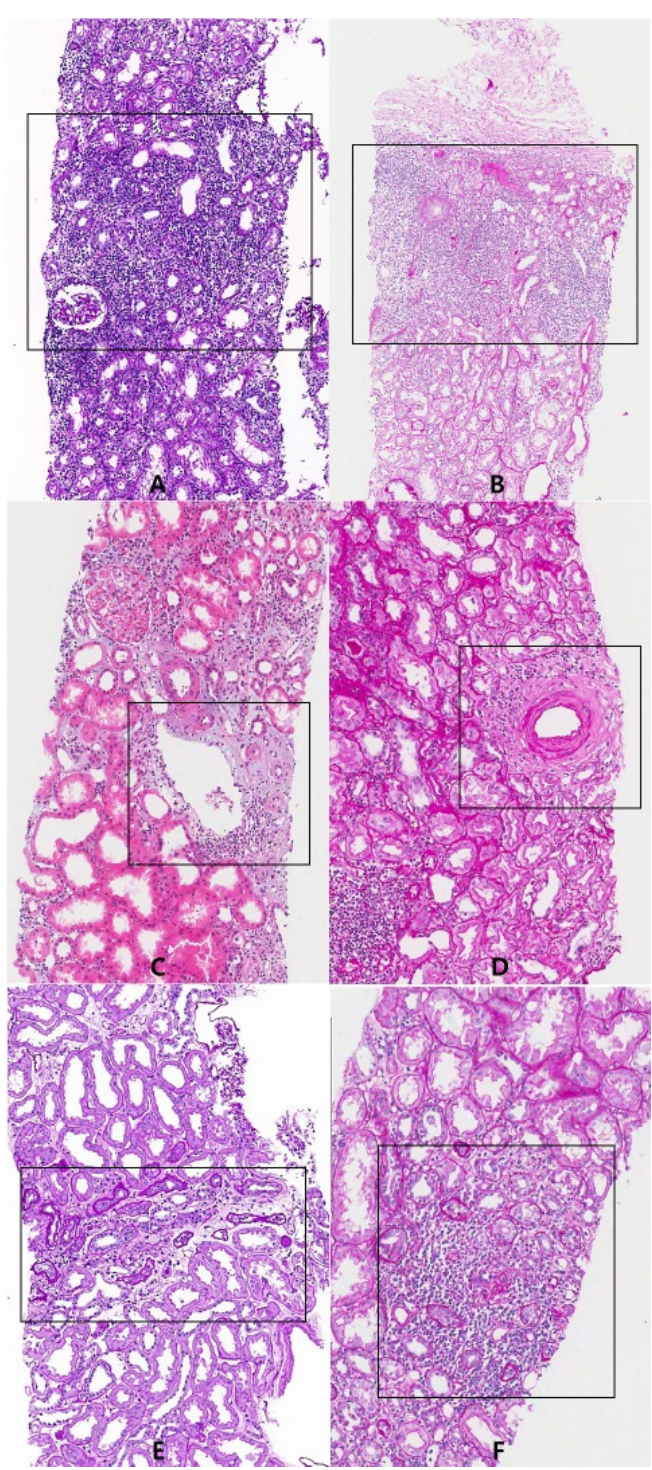
Figure 1. Representative areas of regions of interest (ROIs). ( A ) Cortical interstitial infiltration area (periodic acid–schiff stain, × 100); ( B ) subcapsular area (periodic acid–schiff stain, × 100); ( C ) area surrounding the vein (hematoxylin and eosin stain, × 100); ( D ) adventitia area of artery (periodic acid–schiff stain, × 100); ( E ) medullary ray, longitudinal section (periodic acid–schiff stain, × 100); ( F ) medullary ray, cross section (periodic acid–schiff stain, ×